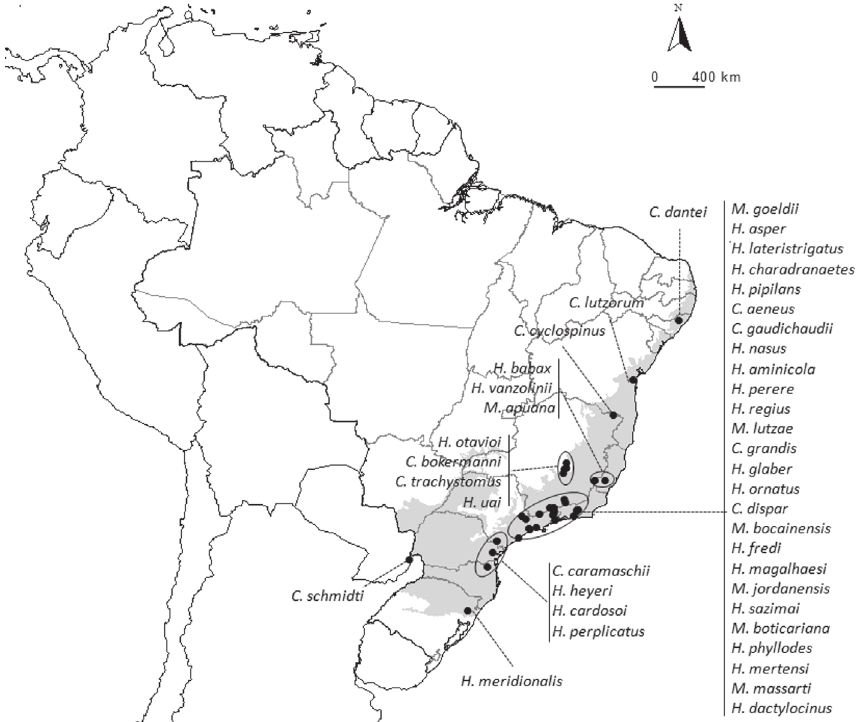
Figure 2. Type-localities of Hylodidae species (source: F ROST 2011). The Brazilian Atlantic Forest biome is highlighted in gray. Source: MMA